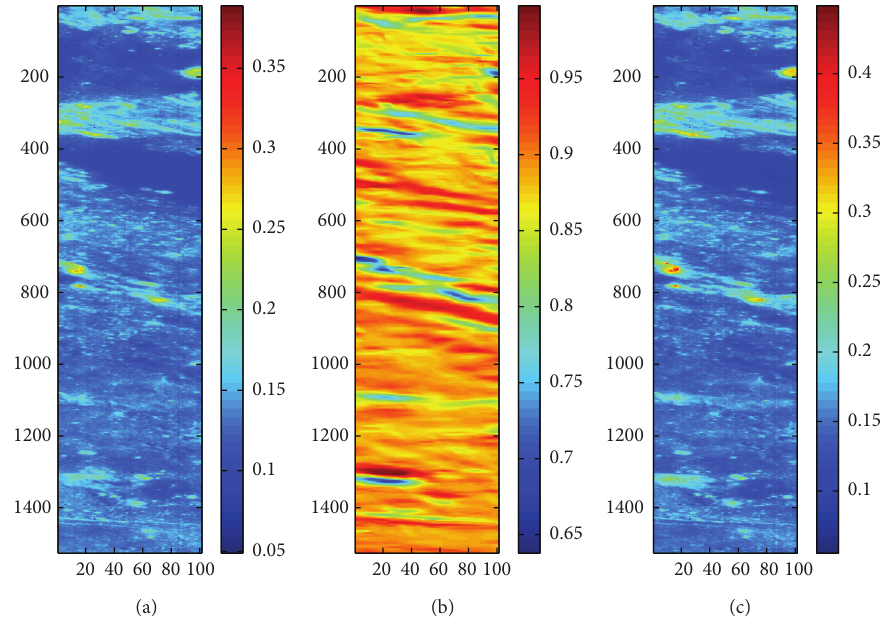
Figure 20: The 2D results of removing the influence of the topography applying our model. (a) 𝑥 - 𝑦 profile of CE-1 IIM data ( 𝜆 = 705 nm); (b) diffusion intensity calculated by CE-1 elevation map of the same region; (c) result obtained by using the inverse process of our method to CE-1 IIM data.